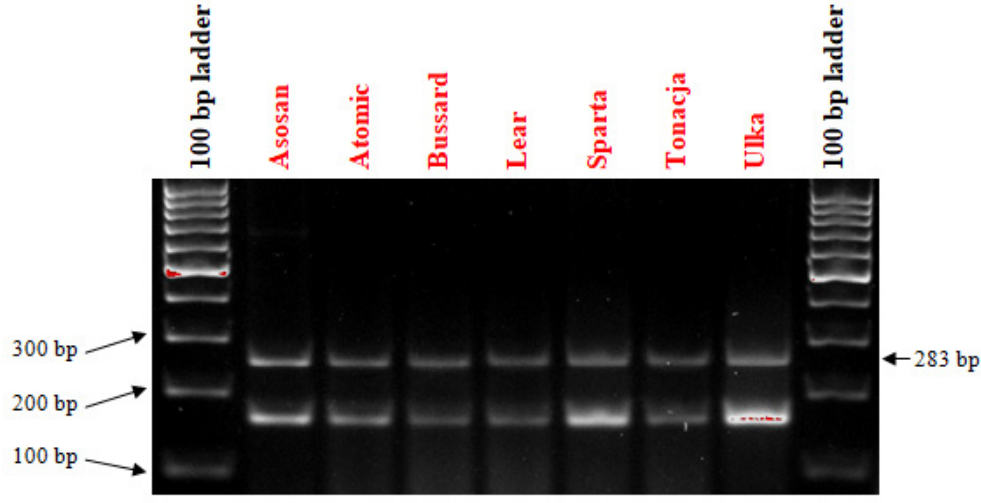
Figure 1: Electropherogram showing the presence of the Xcfd81 marker of the Pm2 gene in wheat